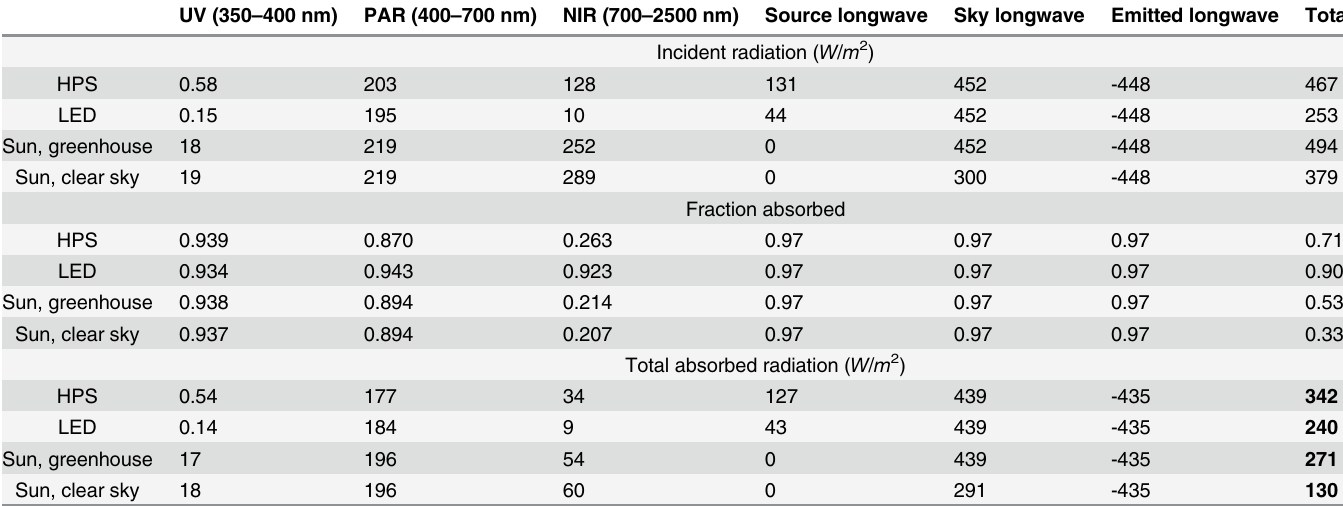
Table 1. Incident radiation, fraction absorbed, and total absorbed radiation for each source. The absorbed radiation was normalized to a PPF of 1000 µ moles per m 2 per s for each radiation source. This does not result in exactly equal PAR (in watts per m 2 ) because of spectral differences among radiation sources. The total absorbed radiation for each source is shown in bold. Leaf temperature was held constant at 25°C. Net longwave exchange with lower leaves or surfaces was assumed to be